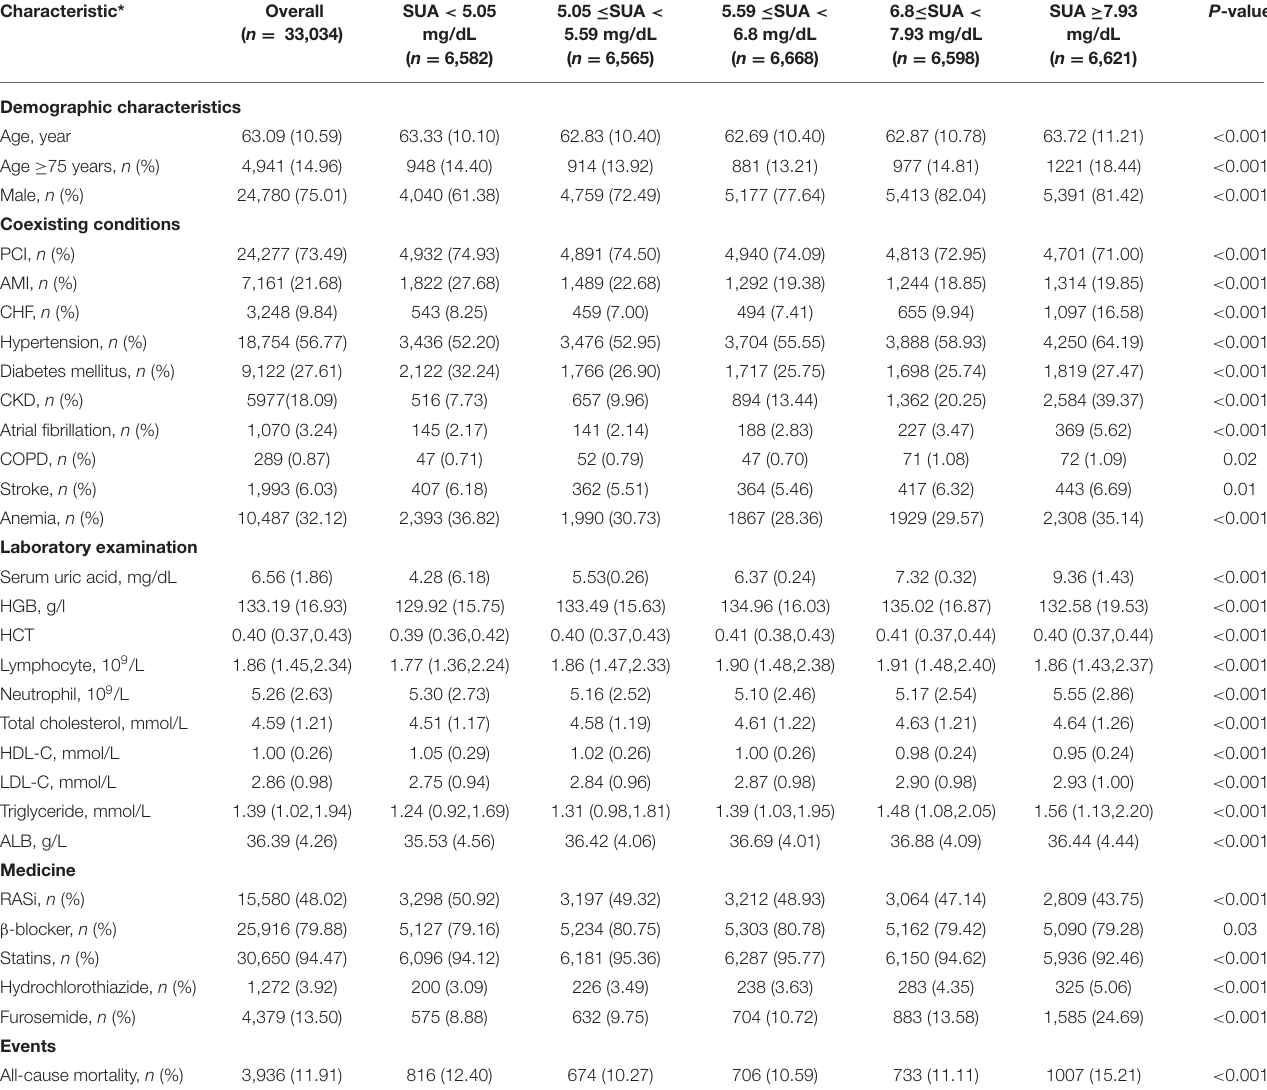
TABLE 1 | Baseline